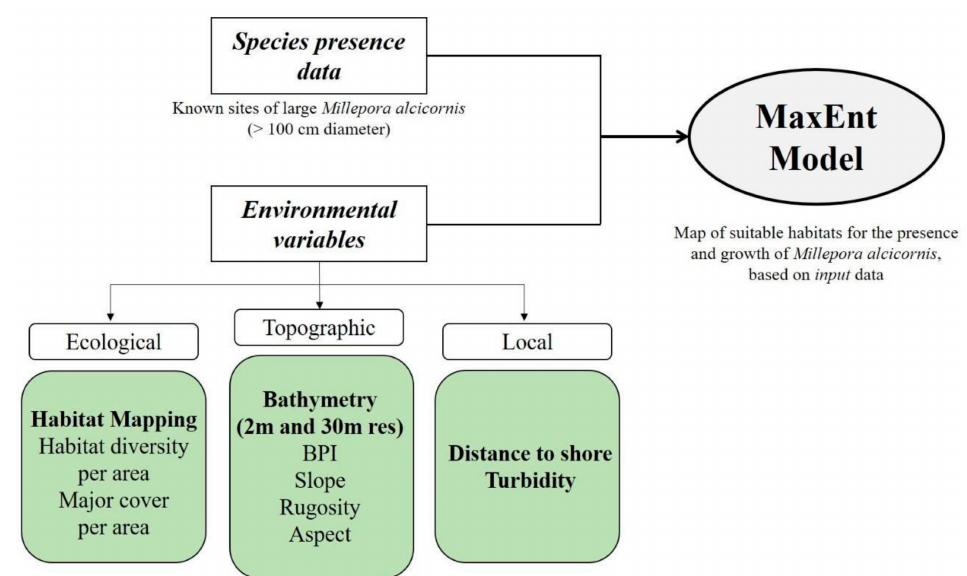
Figure 4. Histogram of the process to derive the predictive distribution model of Millepora alcicornis in